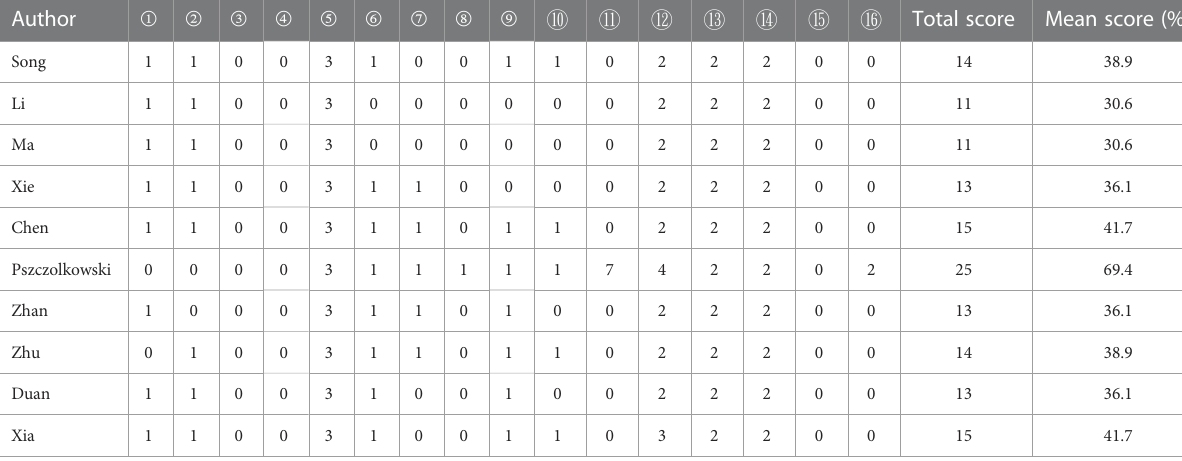
TABLE 2 Radiomics quality scores.